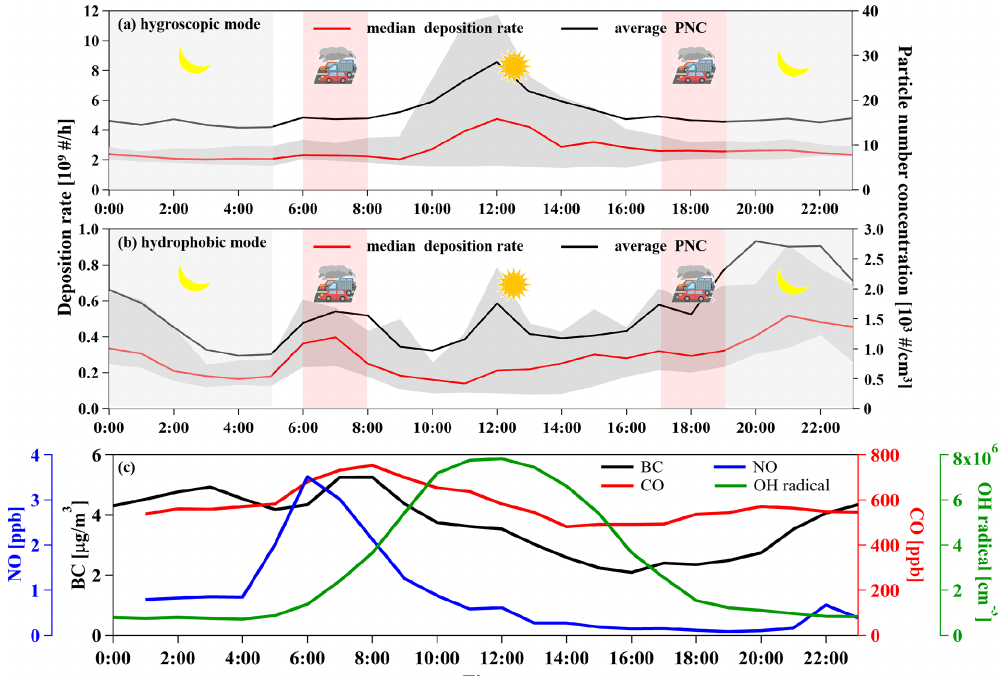
Figure 5. The diurnal variations in deposition rates considering hygroscopicity and particle number concentrations (PNCs) of (a) hygroscopic and (b) hydrophobic particles for adults. The red lines represent the median deposition rate. The upper and lower edges of the gray area represent the 75th and 25th quantiles of deposition rates, respectively. The black lines represent the average PNC. (c) The diurnal variations in the average concentrations of NO, CO, BC, and OH radicals during the sampling period. The blue, red, black, and green lines represent NO, CO, BC, and OH radicals,